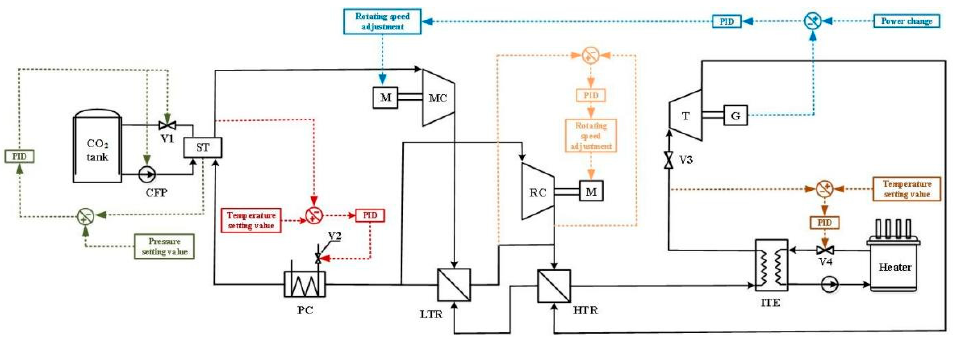
Figure 10. The operation control strategy of the SCO 2 recompression system.